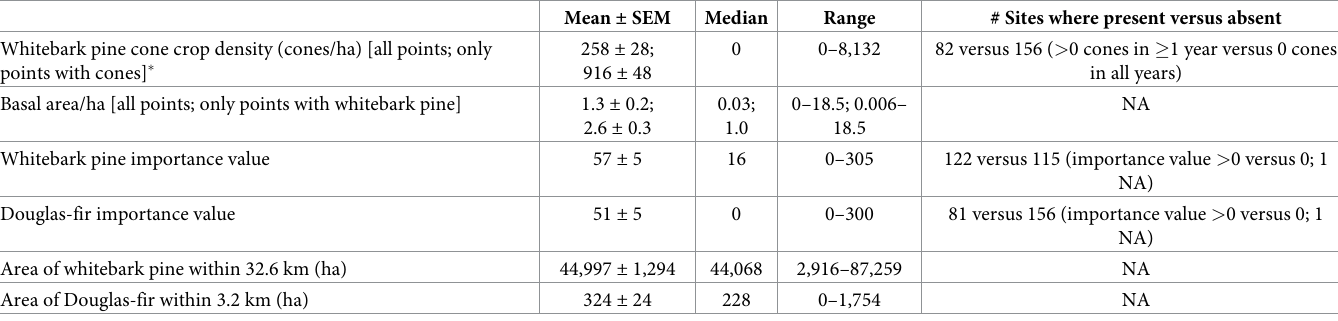
Table 3. Habitat variables at 238 random points.